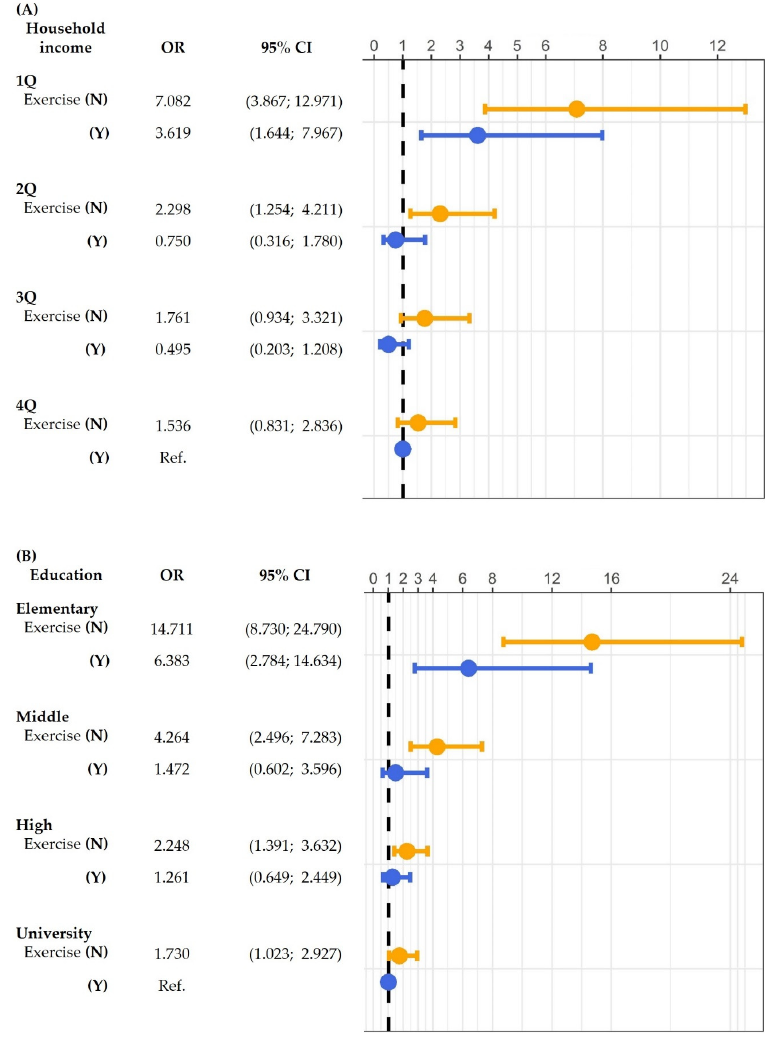
Figure 2. Interaction of ( A ) household income and ( B ) education with muscle exercise: odds ratio (OR) for poor HGS. p -values were calculated using multivariable logistic regression analysis. CI, confidence interval; Q, quartile; N, no; Y, yes; HGS, handgrip strength; Ref., reference.